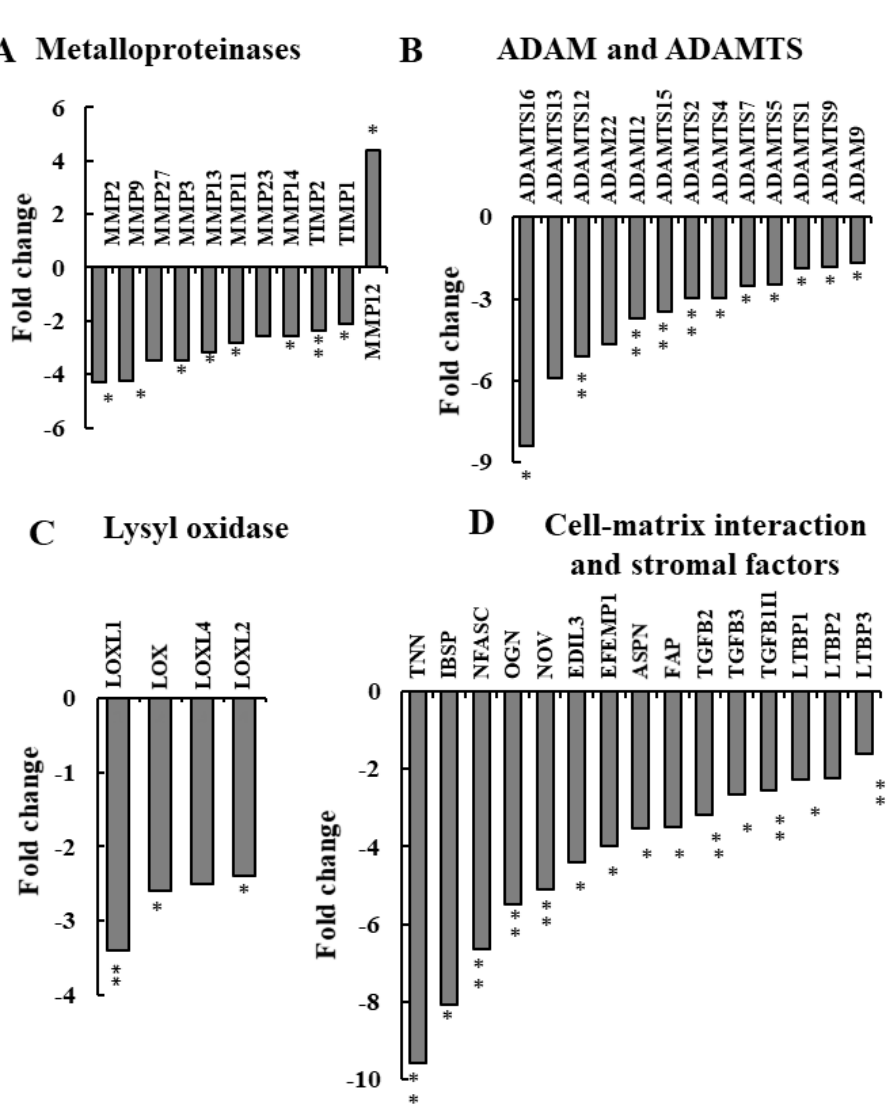
Figure 5 . si ‐ hVDAC1 ‐ 2A reduces the expression of mouse genes involved in ECM deposition and degradation of TME factors. Differentially expressed ECM deposition and degradation genes of murine origin found to be enriched using DAVID Gene Ontology analysis are presented as the fold change in si ‐ VDAC1 ‐ 2A ‐ TTs relative to si ‐ NT ‐ TTs. ( A ) Metalloproteinase genes. ( B ) ADAM and ADAMTS genes. ( C ) Lysyl oxidase and heparan sulphate genes. ( D ) Cell–matrix interactions ‐ and stromal factor ‐ related genes. In all cases, * p ≤ 0.05, ** p ≤ 0.01.